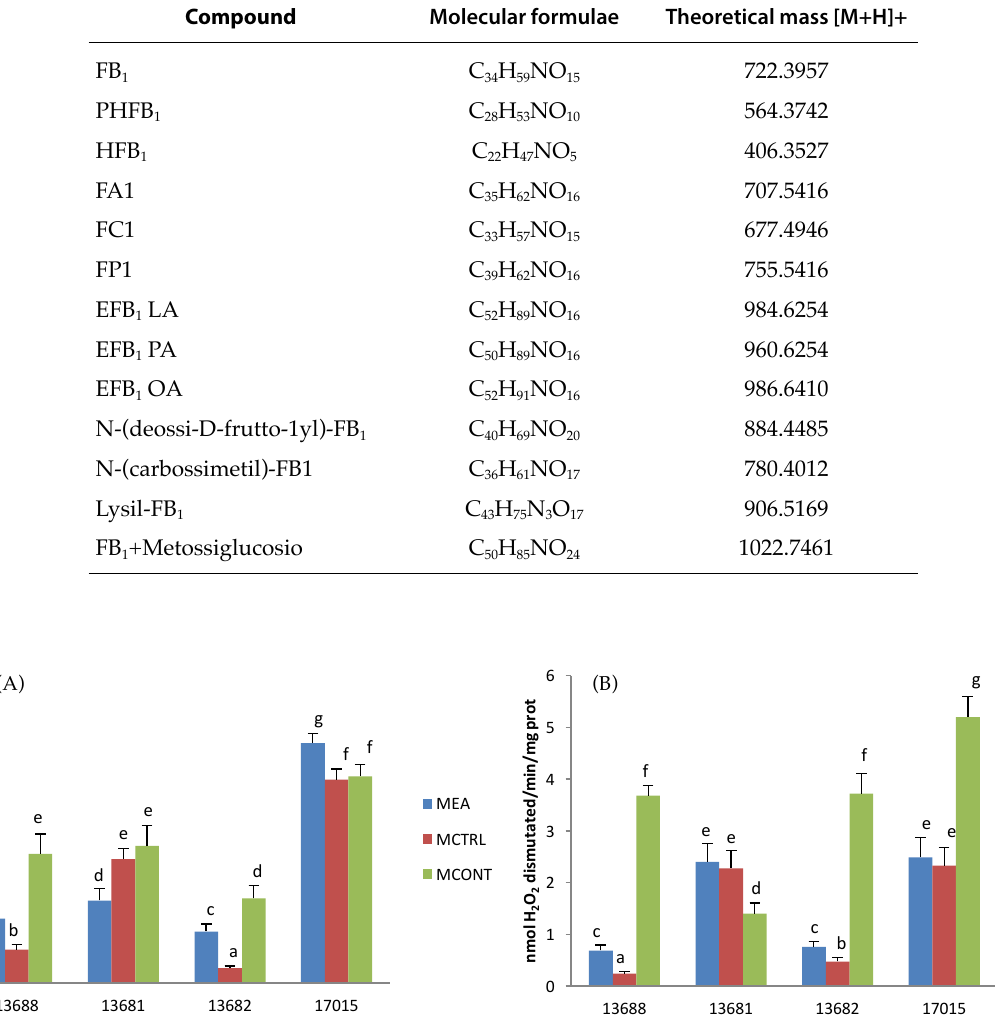
Figure 4. Catalase (CAT) activity in different strains of Pleurotus eryngii grown on agar (MEA), on agar containing non-con- taminated maize (MCTRL) or contaminated maize (MCONT) for 12 (A) or 20 (B) d. Values represent the means of at least three replications from three independent experiments. Same letters over the columns indicate non-significant differences between treatments within each strain ( P <0.05, Duncan’s